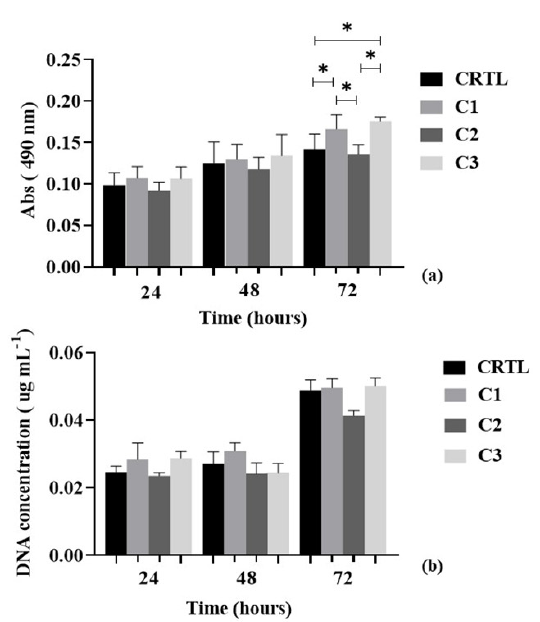
Figure 6. MTT assay ( a ) and DNA quantification ( b ) of chondrogenic primary cells with control (cells with DMEM ‐ 12 medium) and different Ty–GG hydrogels conditions (C1, C2 and C3) for 24, 48 and 72 h. Significant differences * p < 0.05. Nonparametric Kruskal–Wallis test (MTT assay) and Ordinary one ‐ way ANOVA (DNA quantification).